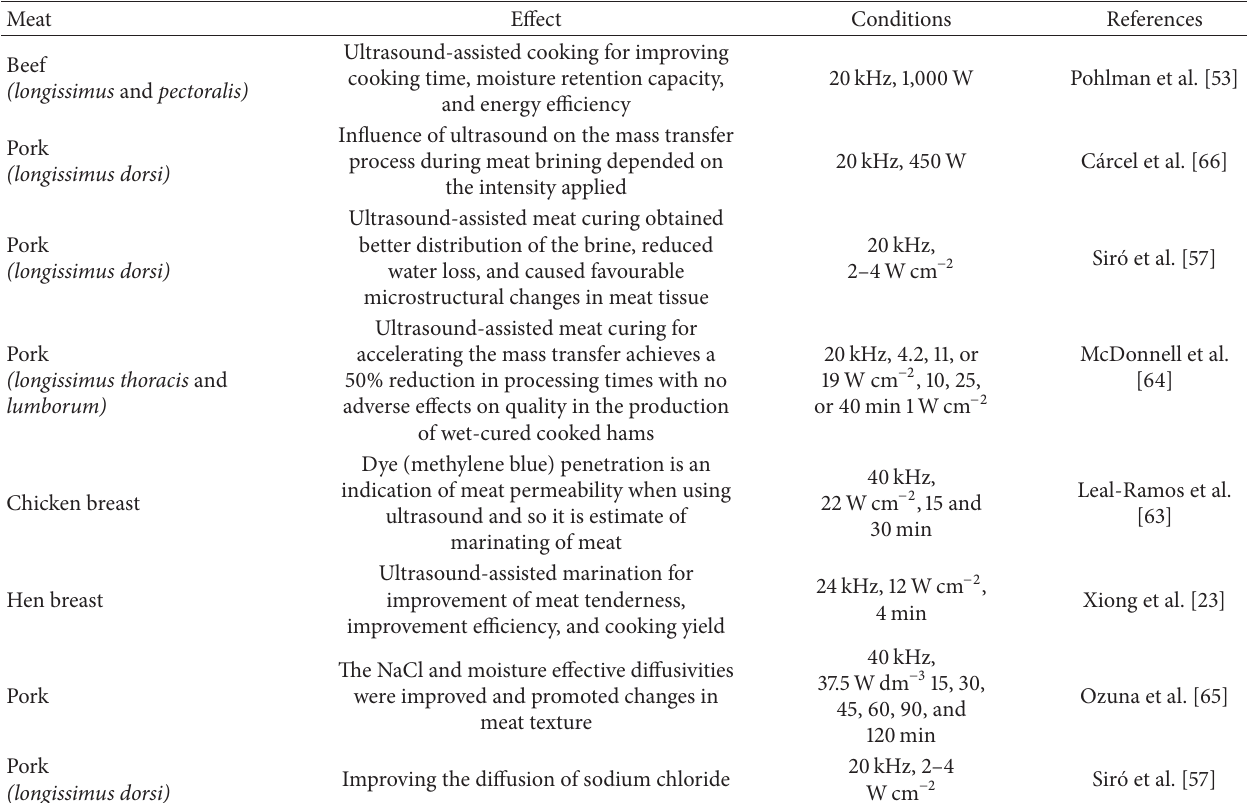
Table 3: Application of ultrasound in meat for various